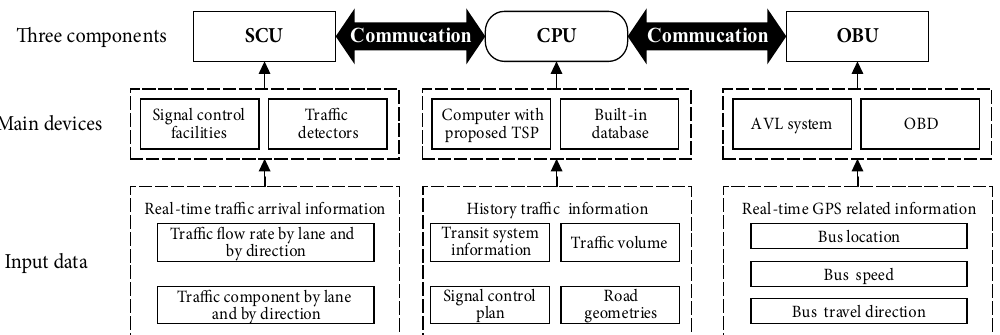
Fig. A1. The framework of the proposed TSP